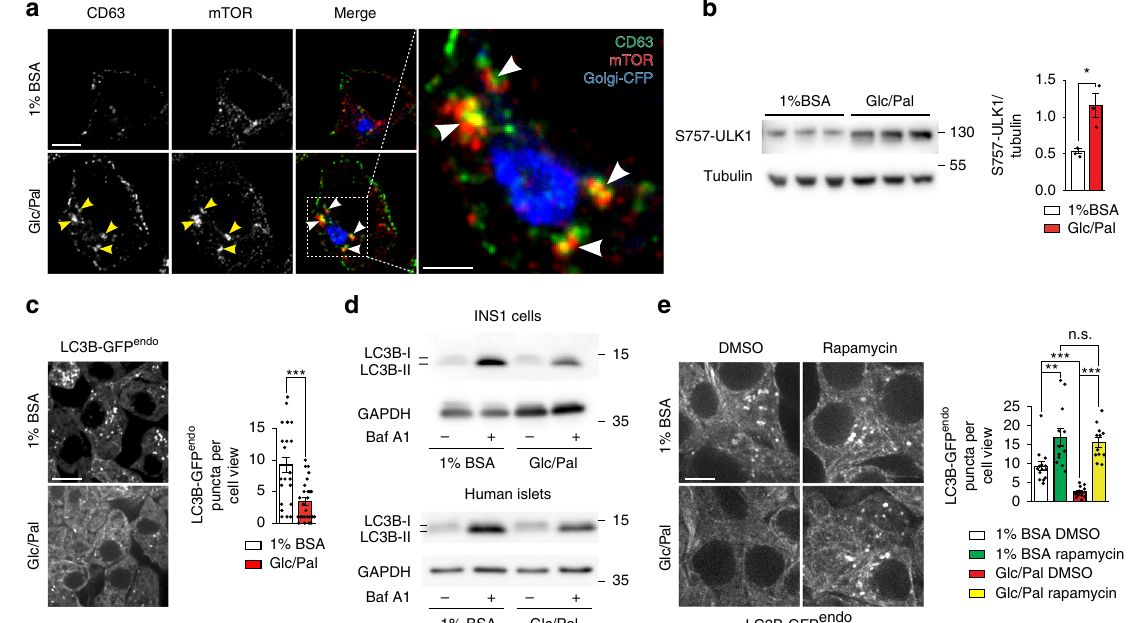
Fig. 2 Glucolipotoxicity leads to mTOR-dependent inhibition of macroautophagy in β cells. a Immuno fl uorescence of CD63 (green) and mTOR (red) in INS1 cells treated with control (1% BSA, 11 mM glucose, “ 1% BSA ” ) or glucolipotoxic (1% BSA, 33.3 mM Glucose and 0.4 mM Palmitate, “ Glc/Pal ” ) media for 20 h. Golgi-CFP was used to visualize the Golgi apparatus. Arrowheads point to large CD63/mTOR puncta. Scale bar, 5 μ m; for inset: 2 μ m. 3D reconstruction is shown in Supplementary Movie 2. b Immunoblot of S757-ULK1 using lysates of INS1 cells treated with 1% BSA or Glc/Pal media for 48 h. Tubulin was used as a loading control. Quanti fi cation of S757-ULK1/Tubulin ratio. N = 3 per group; * P < 0.05, two-tailed t -test. c LC3B-GFP endo puncta